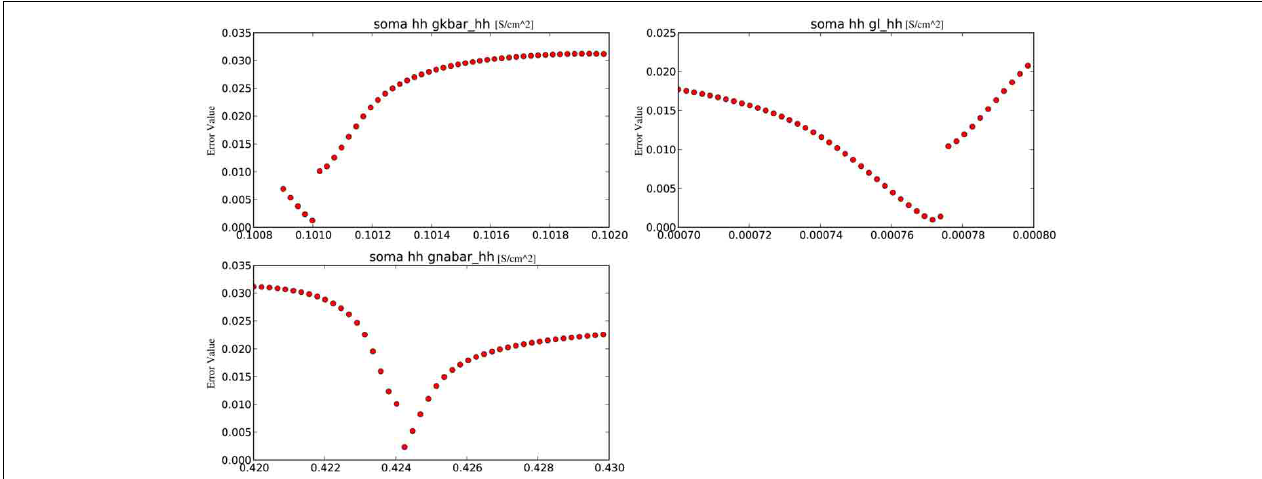
FIGURE 3 | An example of the grid plot of Optimizer, showing one-dimensional slices of the error as a function of the parameters, in the vicinity of an optimum found by the software.